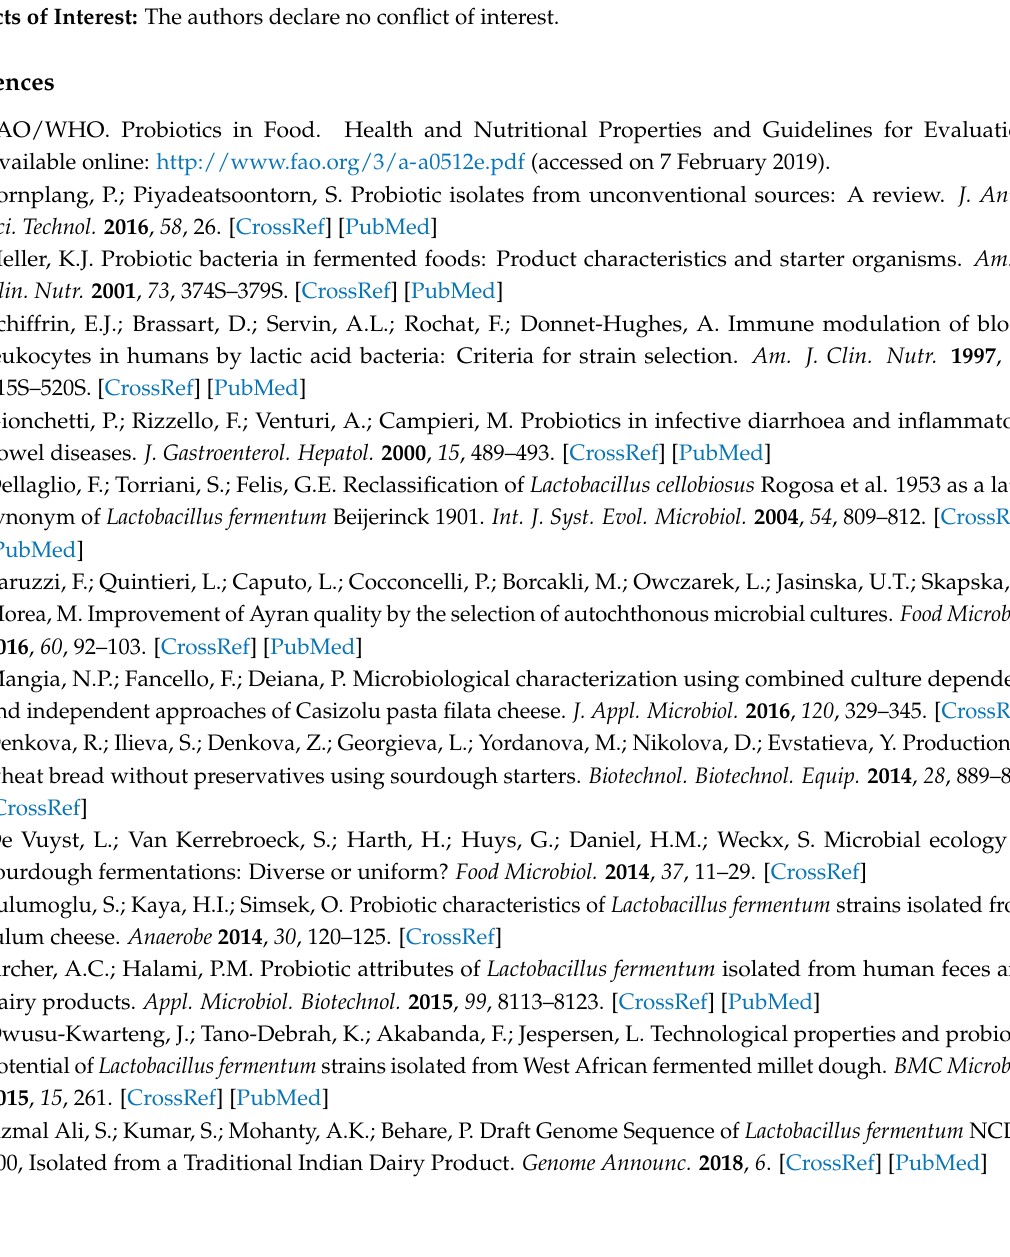
Figure S1: Effect of L. fermentum MBC2 on body size and nematode fertility; Figure S2: Effect of L. fermentum MBC2 on pumping rate and body bending in PEPT-1